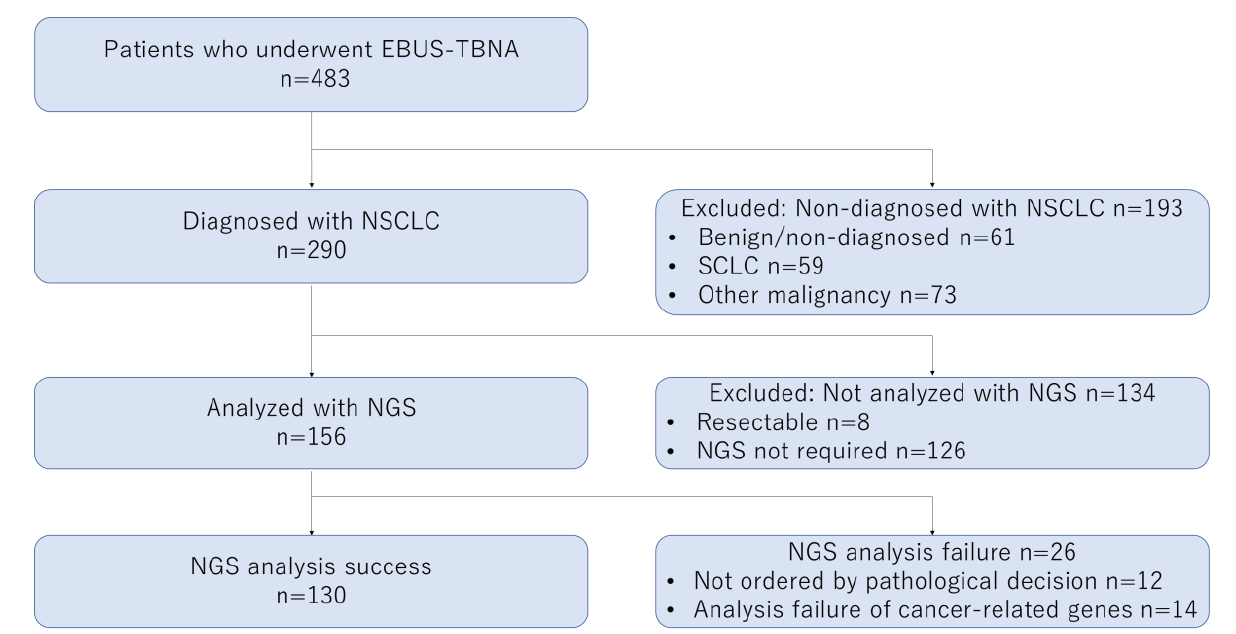
Figure 2. Flow diagram for next-generation sequencing (Oncomine TM Dx Target Test). EBUS-TBNA, endobronchial ultrasound-guided transbronchial needle aspiration; NSCLC, non-small cell lung cancer; SCLC, small cell lung cancer; NGS, next-generation sequencing.